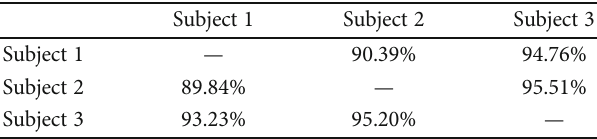
Figure 6: The pseudo real-time recognition decisions. The upper subplot is the raw pitch angles and the detected extreme points. The bottom subplot shows the recognition decisions and the reference Table 2: Training/testing with whole data of a subject (1 :2 intersubject validation).